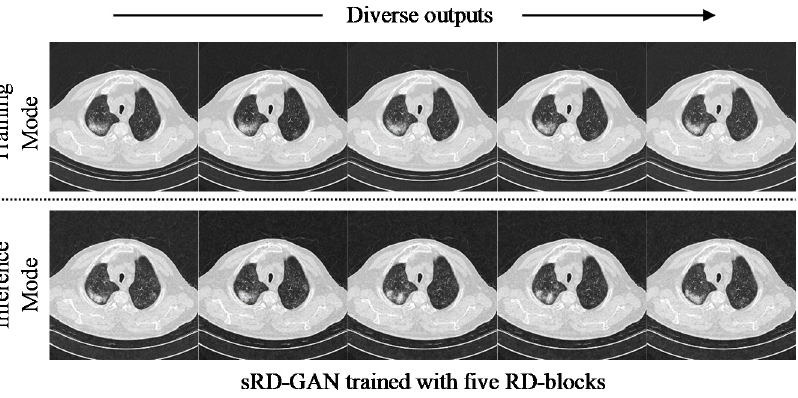
Figure 5. Synthetic COVID-19 CT images generated in training and inference modes, where the diverse outputs generated in inference mode show more apparent differences between the synthetic instances.